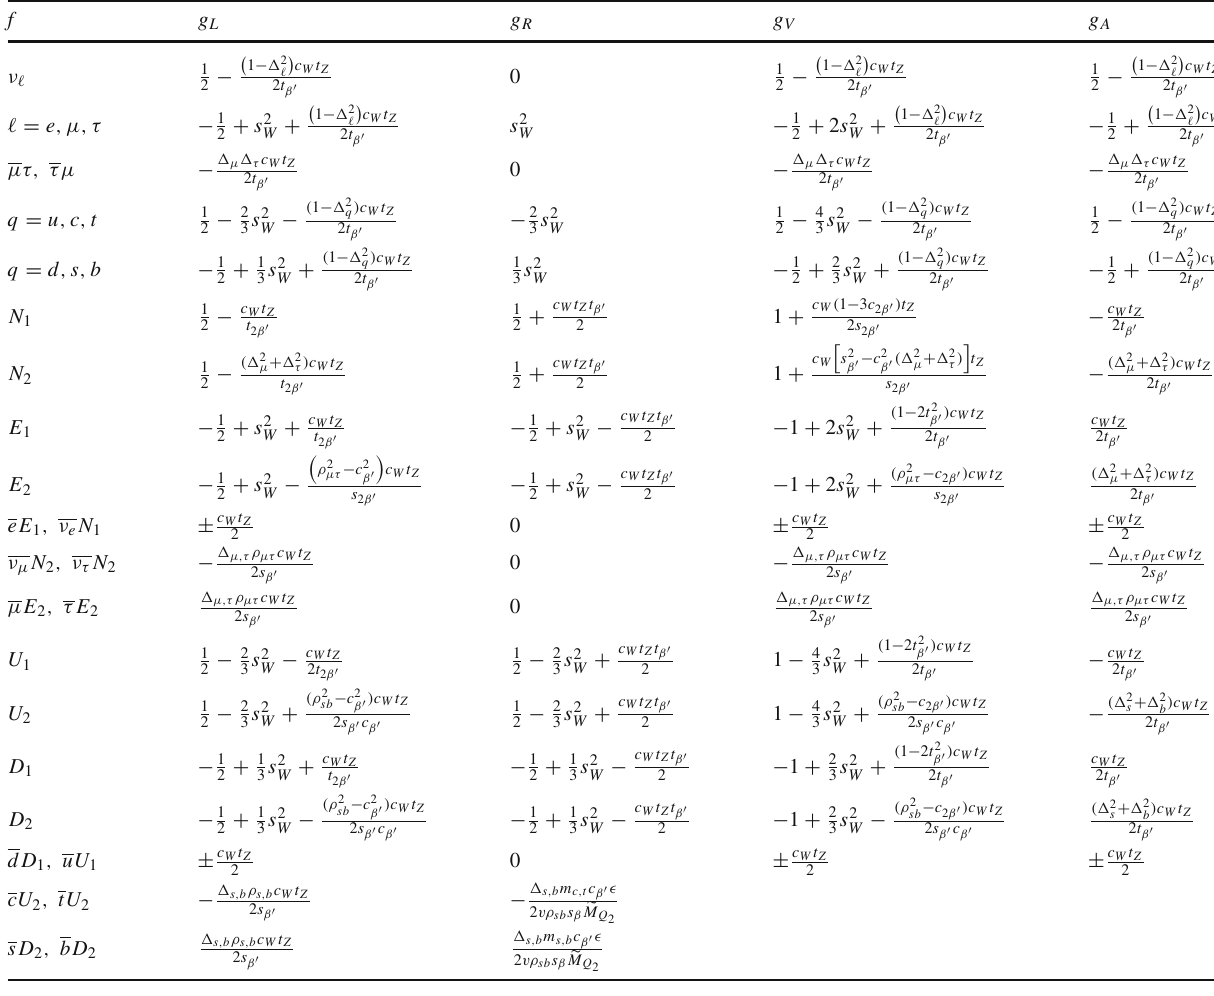
Table 1 Couplings of Z boson with fermions, (cid:8) = e ,μ,τ and (cid:14) e = (cid:14) d = 1